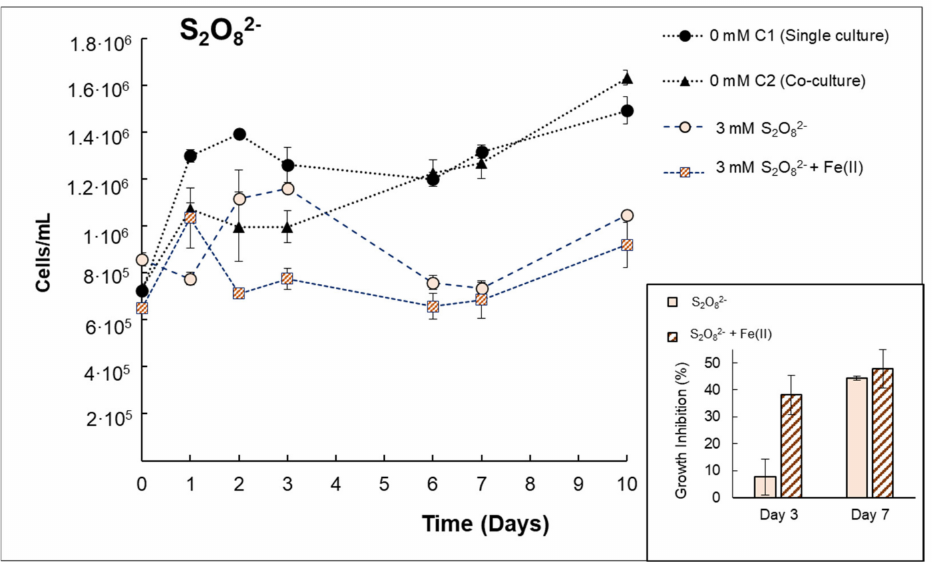
Figure 4. Growth curves of Anabaena sp. in co-culture with V. alginolyticus for single S 2 O 82 − or S 2 O 82 − + Fe(II) treatments. Inset: Specific growth inhibition (%) obtained on day 3 or 7 for Anabaena